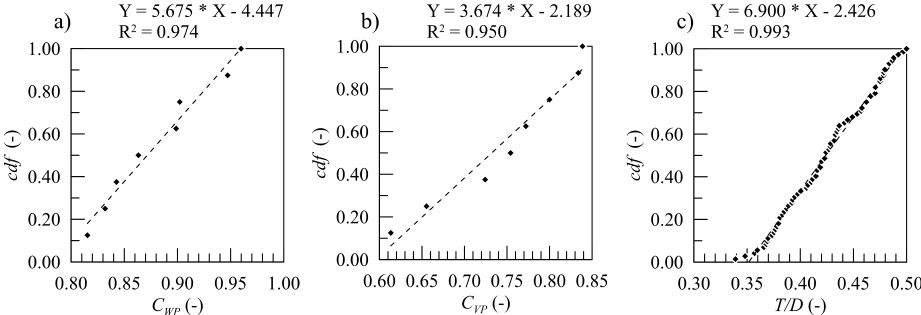
Figure 4. Cumulative Density Function of the C WP , the C VP and T / D parameter.